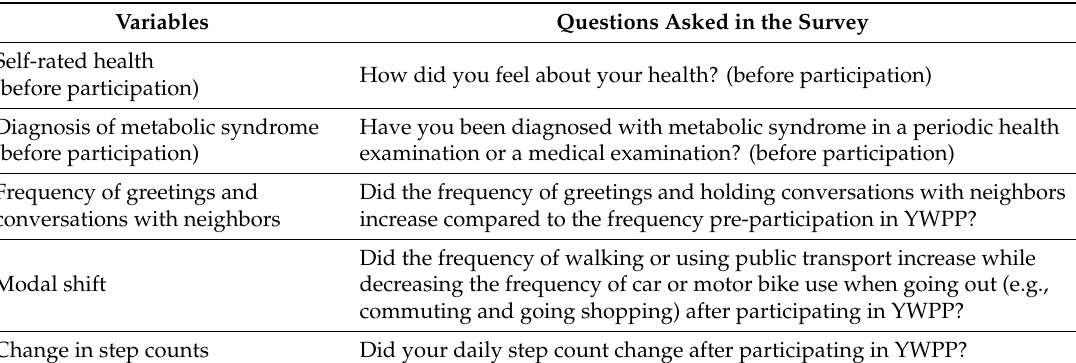
Table A1. Questions asked in the